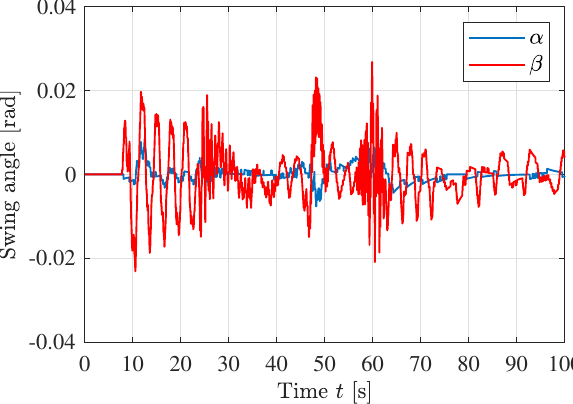
Figure 25: Swing angles with anti-swing control.